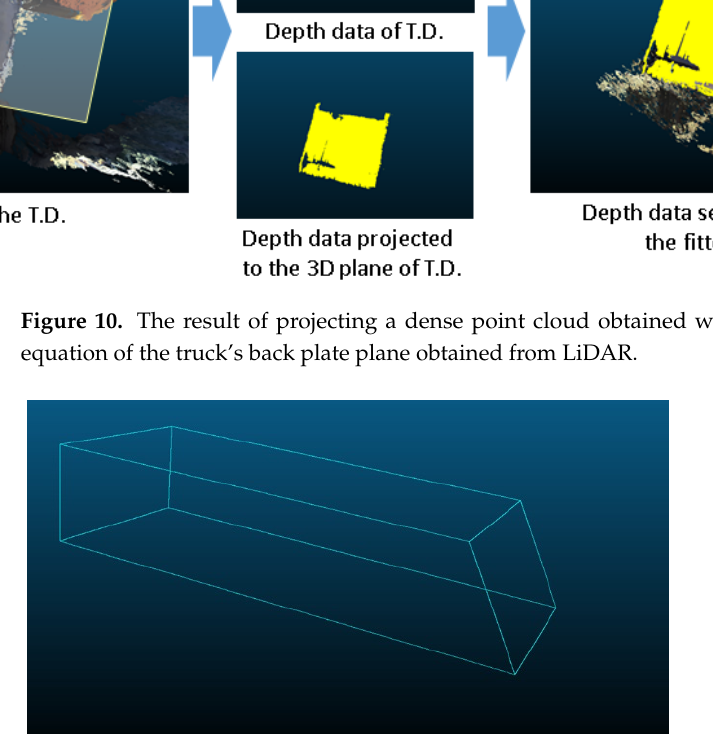
Figure 11. Three-dimensional model of the cargo area.